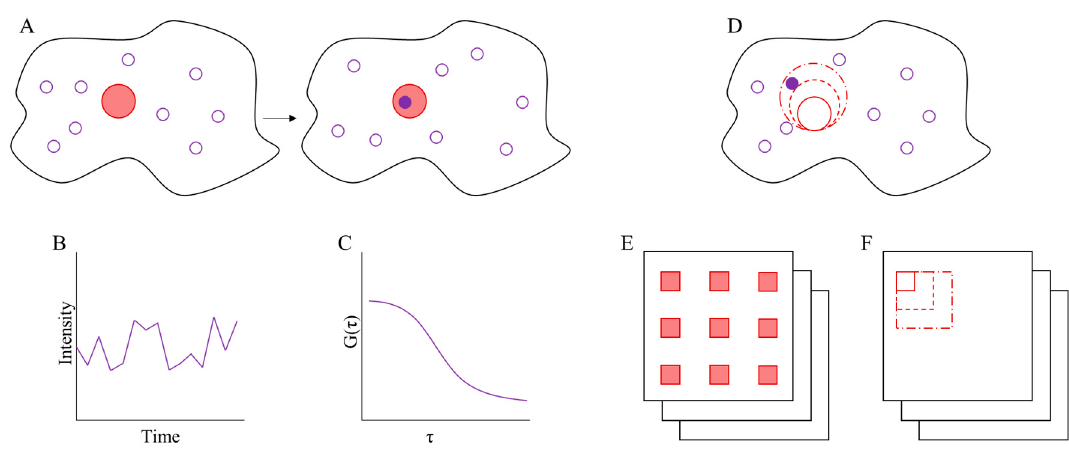
Figure 3. A schematic overview of FCS basics and techniques. ( A – C ) shows the basic principle in FCS fluorescence fluctuation analysis. ( A ) Shows that when a fluorescent particle (purple circle) di ff uses into the laser focal spot (red circle) on a cell (black circle), it will be excited and emit fluorescence photons which are collected and detected. The random movement of fluorescent molecules in and out of the laser focal spot will result in a fluctuating intensity plot which reflects changes in the number of fluorophores in the focal spot as seen in ( B ). A time auto-correlation function of the fluctuations is calculated and fitted with an appropriate decay function as seen in ( C ). Measurement of the focal spot radius combined with the characteristic fluctuation time from the autocorrelation fit allows calculation of D for the fluorescent molecules. ( D – F ) Illustrates the di ff erent variants of FCS techniques described in the main text. ( D ) Shows the svFCS where the laser focus area is increased, which is utilized to measure the di ff usion coe ffi cient and test for confinement on di ff erent spatial scales. ( E ) Illustrates the imFCS method where the fluorescence fluctuation analysis is applied to an image stack over multiple region of interest (ROI), where each red square corresponds to an individual ROI. ( F ) Showcases bimFCS, which is in principle the imaging version of the svFCS.